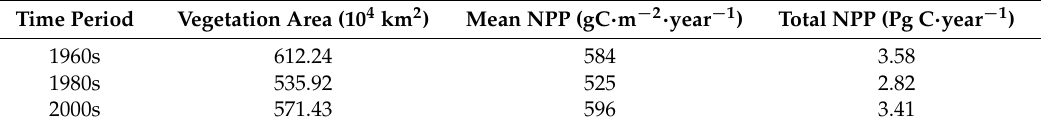
Figure 4. Trends of NPP from the 1960s to 2000s: ( a ) variation in the vegetation NPP from the 1960s to the 2000s; ( b ) variation in the vegetation NPP from the 1960s to the1980s; and ( c ) variation in the vegetation NPP from the 1980s to the 2000s. Table 1. The total and mean NPP of Chinese vegetation in 1960s, 1980s, and